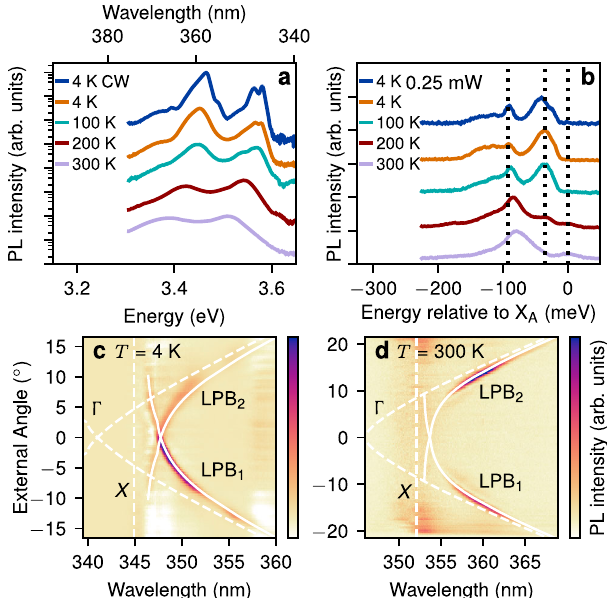
Fig. 2 Photoluminescence (PL) characterisation. a PL spectra emitted inside the light cone (near zero in-plane momentum) showing exciton and buffer layer emission for various temperatures. Curves are vertically offset for visibility and plotted on a logarithmic scale. CW denotes continuous- wave excitation. b Polariton PL spectra after propagating 50 μ m from the excitation spot to the gratings (see Fig. 1b). Vertical black dashed lines are at the QW A exciton frequency and 35 meV and 92 meV below the A exciton frequency. c , d Angle-resolved polariton PL spectra at temperatures T = 4 K ( b ) and T = 300 K ( c ). The solid white curves (LPB 1 and LPB 2 ) denote the best fi t forward and backward propagating lower polariton branches. The dashed white curves ( Γ ) give the calculated uncoupled photon dispersion. The dashed vertical line ( X ) denotes the exciton frequency. The exciton emission has been subtracted to highlight the polariton modes (see ‘ Methods ’